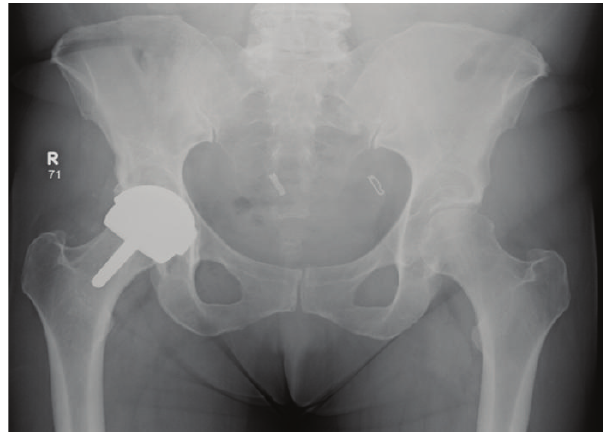
Figure 1: Pelvis radiograph from 2009.